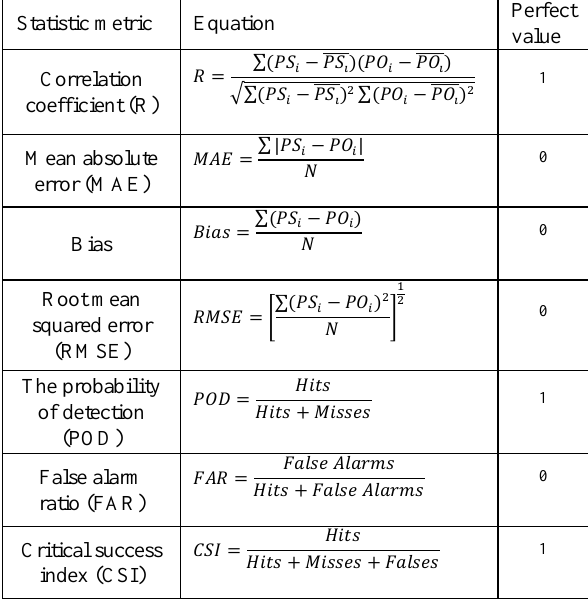
Table 1. Statistical List of Criteria Used for Comparison and Statistical Evaluation